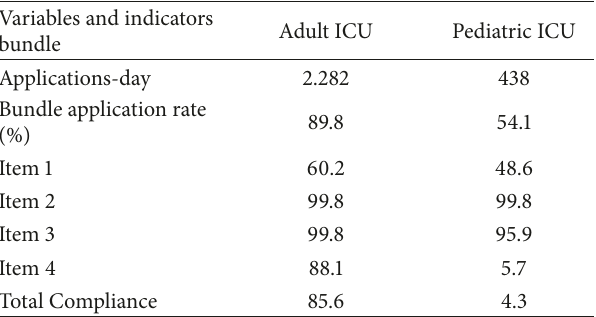
Table1:VariablesandbundleindicatorsinadultandpediatricICUs. Central Brazil.